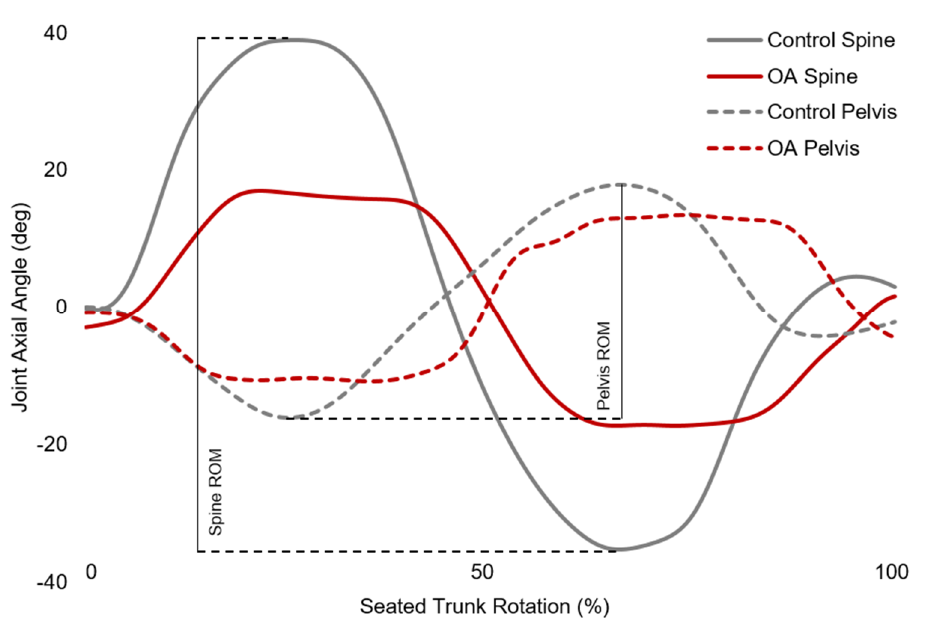
Figure 3. Kinematic axial spine (solid lines) and pelvis (dashed lines) assessments during a time-normalized (0–100% cycle) Seated Trunk Rotation (STR) task, as an example of data assessment for one control and one osteoarthritis (OA) participants. The thin vertical black lines demonstrate how range of motion (ROM) were assessed.